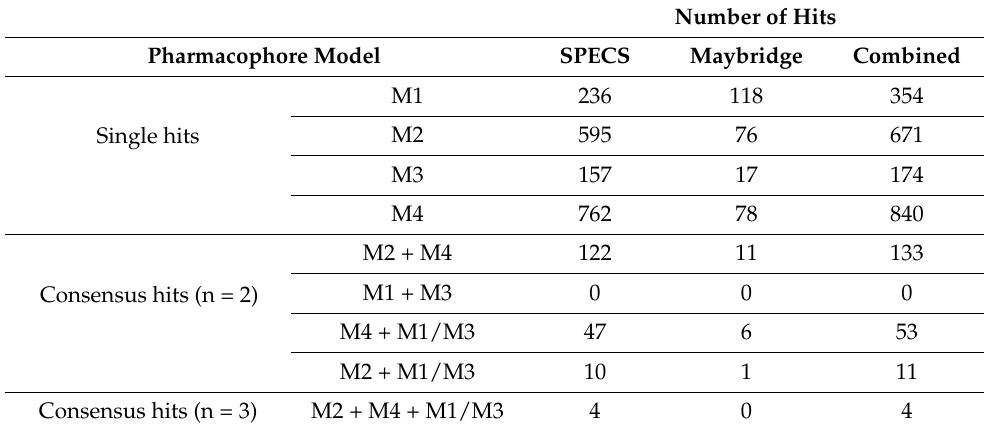
Table 2. Summary of virtual hits after screening and filtering of the SPECS and Maybridge databases. The SPECS and Maybridge databases were screened separately with the four individual phar- macophore models generated in DS and LS. Double and triple consensus hits refer to different combinations of virtual hits from the single-hit groups.